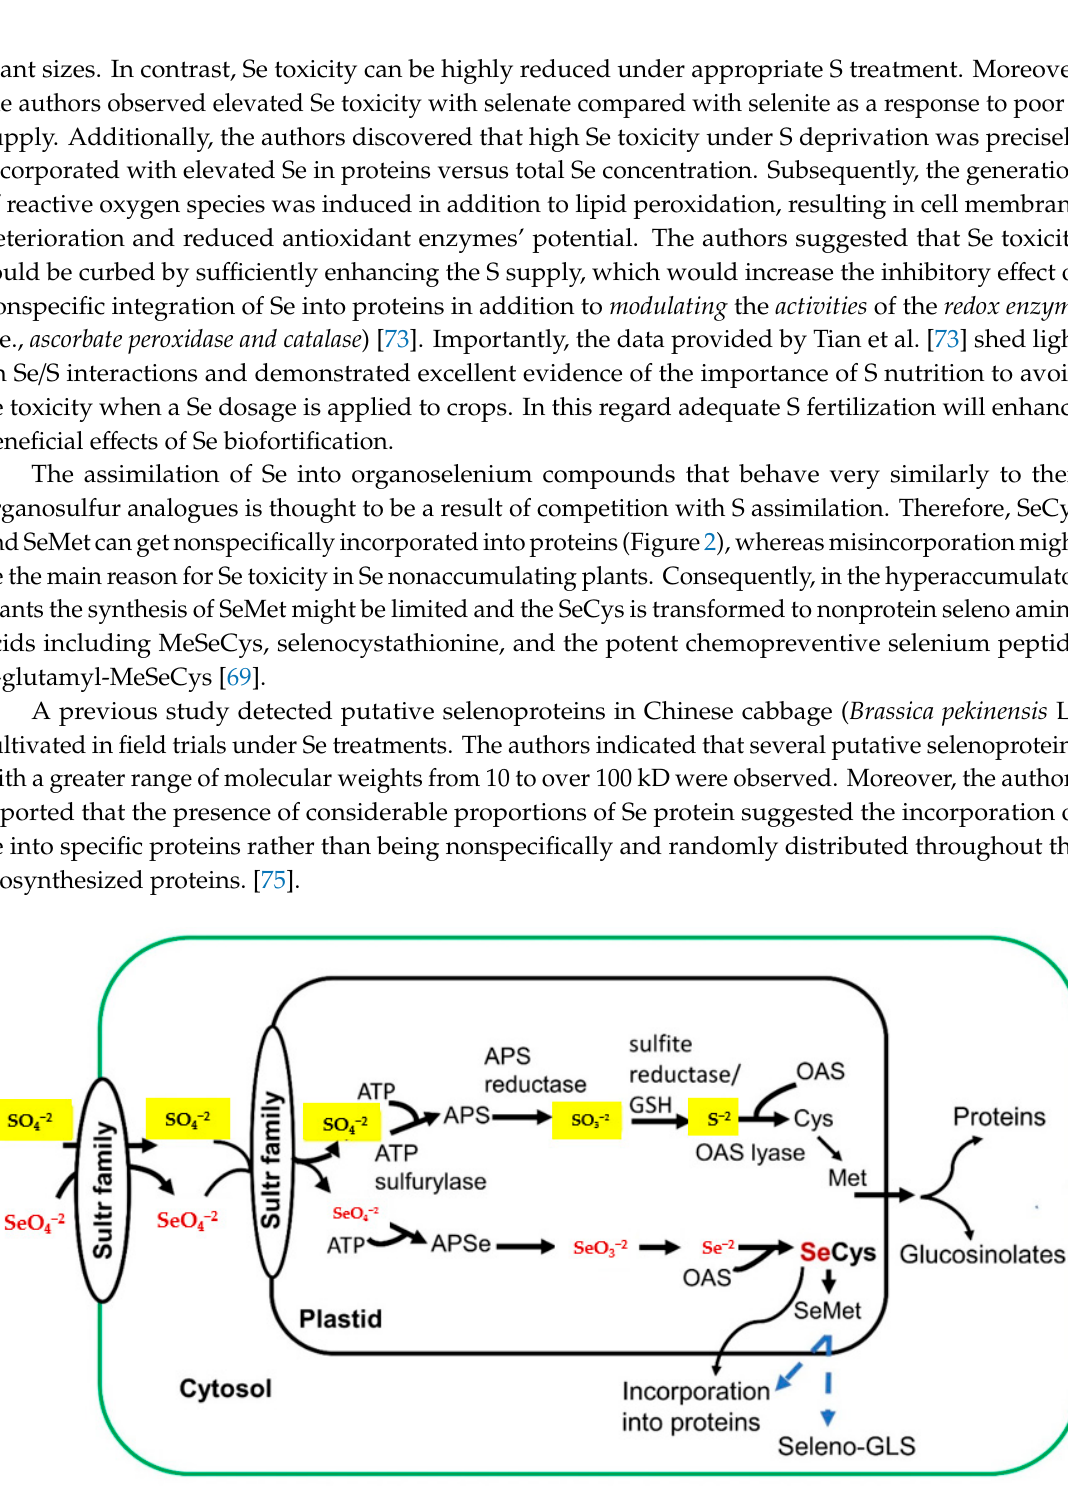
Figure 2. Sulfate and selenate acquisition and assimilation pathways in Se accumulators [74]; Sultr; sulfate / selenate transporters; ATP sulfurylase; adenosine-5’-triphosphate sulfurylase, APS; adenosine-5’-phosphosulfate, OAS; O -acetylserine, APSe; adenosine phosphoselenate. GLS;